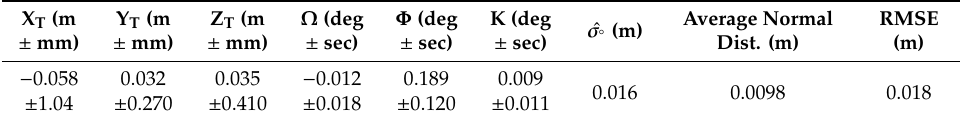
Table 3. Estimated transformation parameters and quality measures (square root of a-posteriori variance factor, average normal distance among point-patch pairs, and RMSE of the normal distances) following the registration of the MLS point clouds from di ff erent drive runs at Site-1.